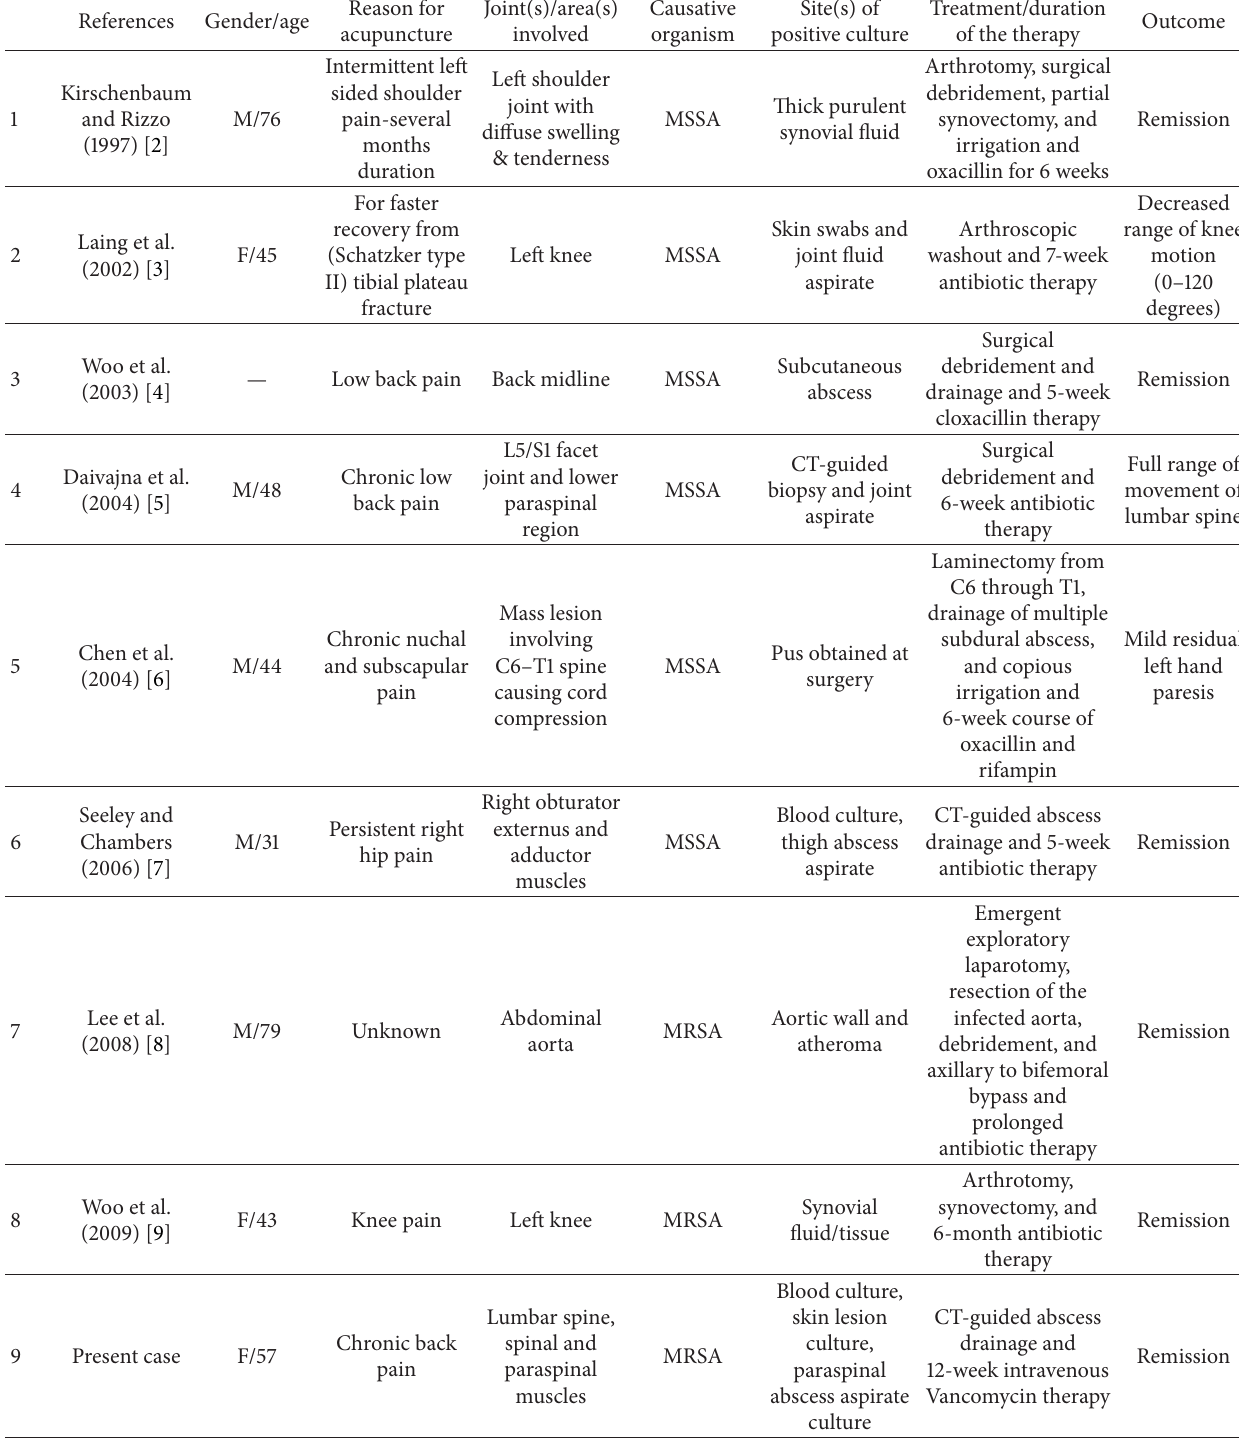
Table 1: Infectious complications related to acupuncture (MSSA and